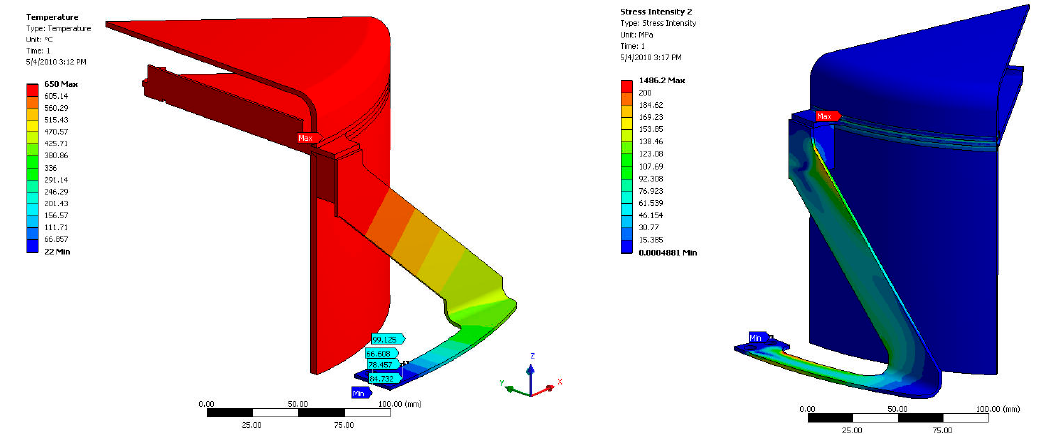
Figure 1. Temperature distribution ( left ) and stress field ( right ) within the designed thermal energy storage (TES) flexure.